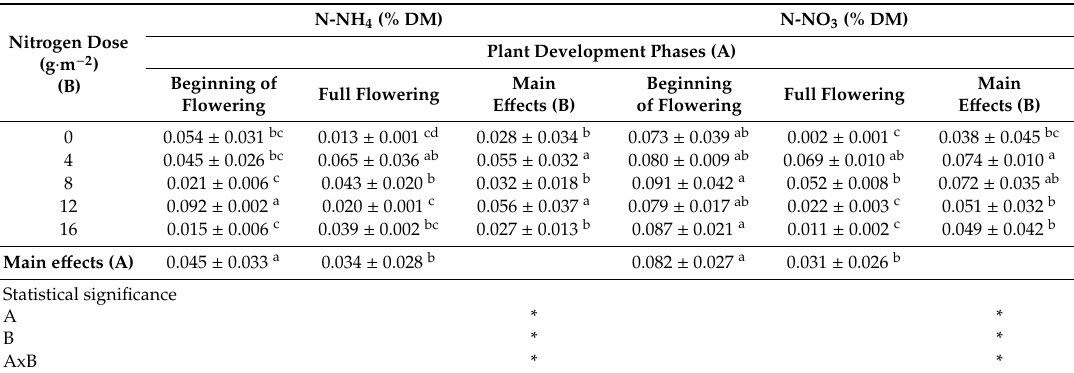
Table 1. E ff ect of the nitrogen dose and plant development phases on the content of nitrogen forms of summer savory herb (in 2014–2016) (Note: The results are presented as the mean ± SD; means sharing the same letter in a column do not di ff er significantly according to Tukey’s test at p ≤ 0.05; significant e ff ects for the main factors and for interaction between them are indicated with asterisks (*); n.s.—no